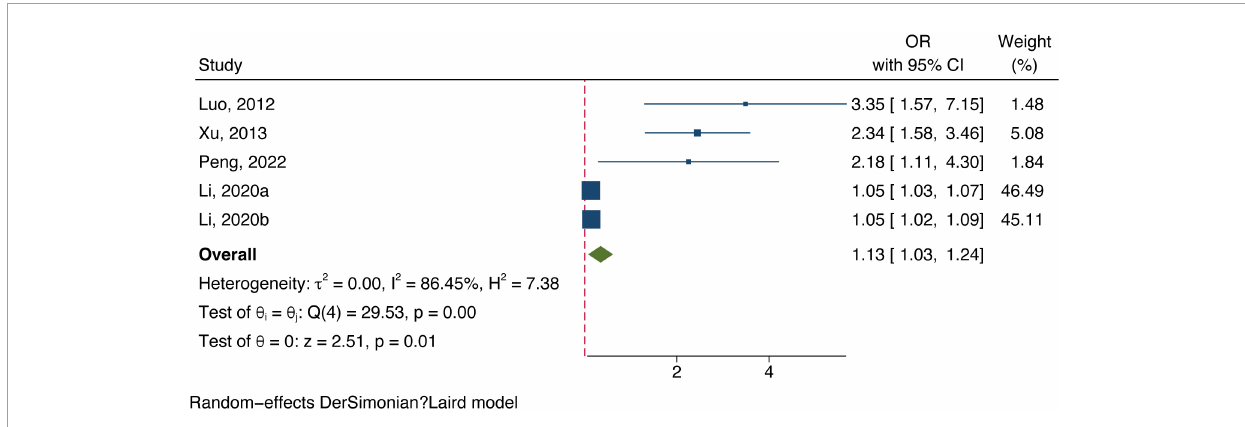
FIGURE4 Forest plot of the association between total bilirubin level and ischemic stroke severity.